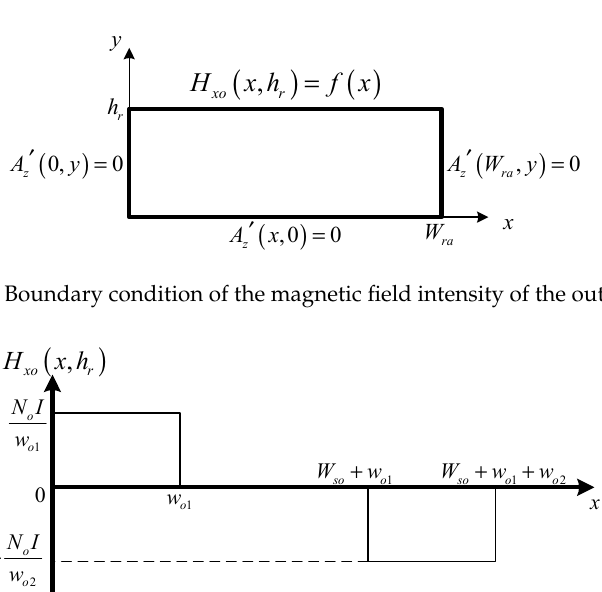
x h . Figure 11. Expression of magnetic field intensity H xo ( x , h r ) xo